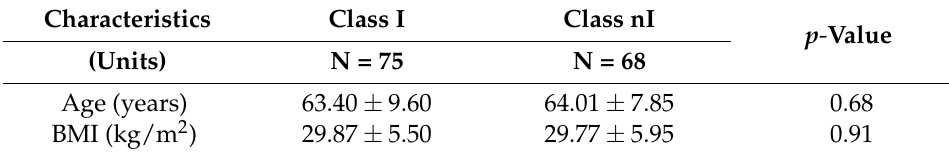
Table 3. Demographic characteristics of the female participants within each